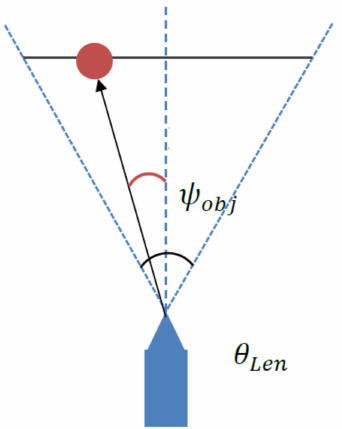
Figure 5. Calculation of Azimuth angle.